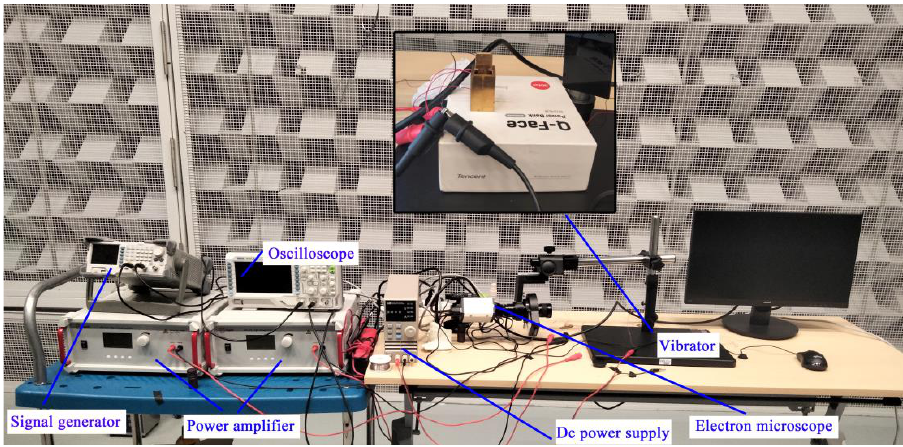
Figure 10. Experimental setup for testing the vibration responses of dust deposited on the surface of the vibrators.